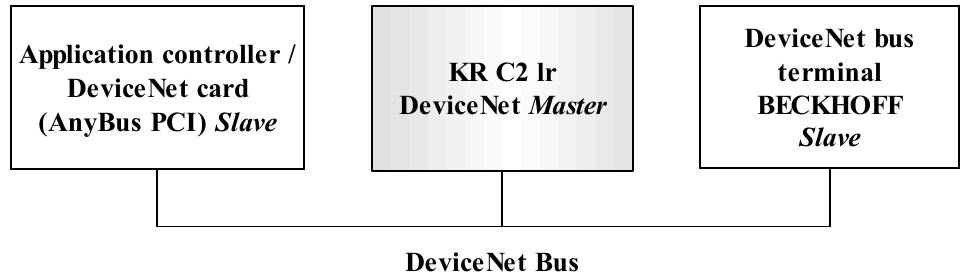
Figure 8. DeviceNet link. The data in the bus can be written/read by any of the connected